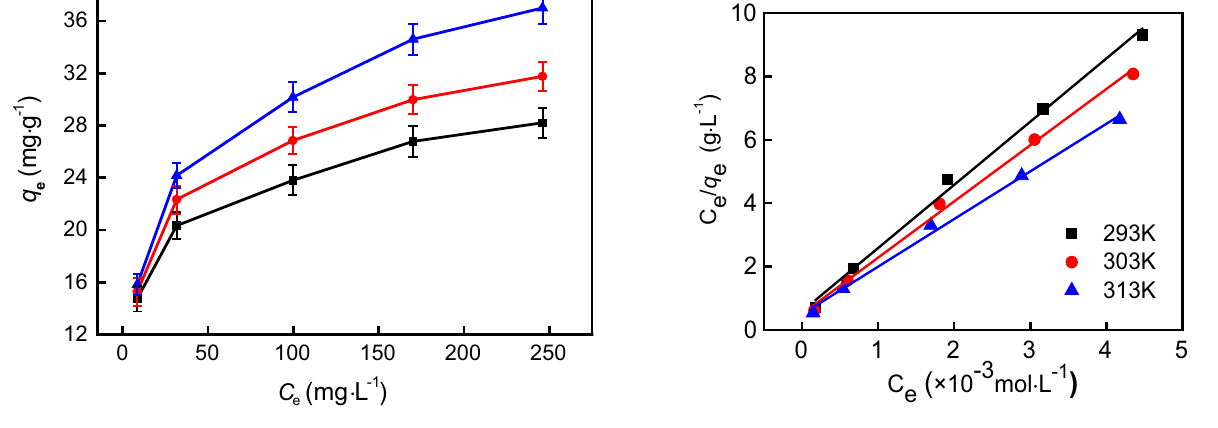
Fig. 7 Langmuir plots for the adsorption of Co(II) onto the DTC resins at different